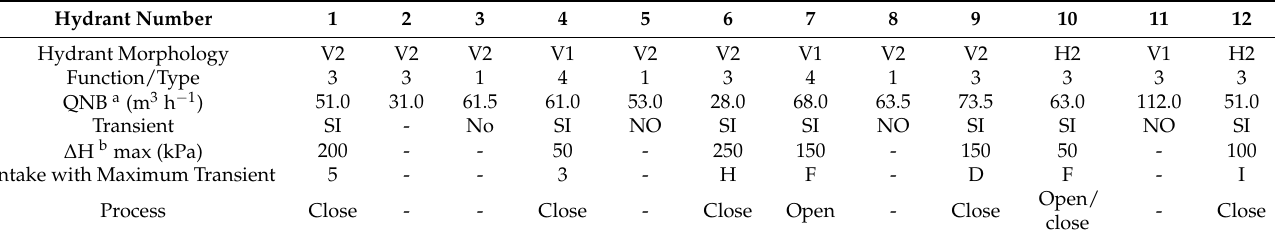
Table 7. Results of hydraulic transients in the opening and closing of